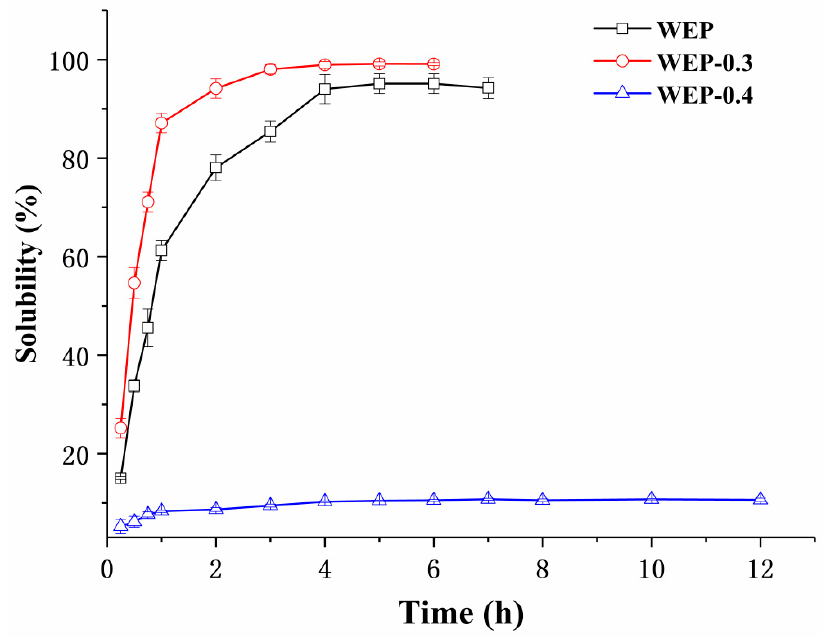
Figure 2. The solubility of WEP, WEP-0.3 and WEP-0.4 in water as a function of dissolution time.